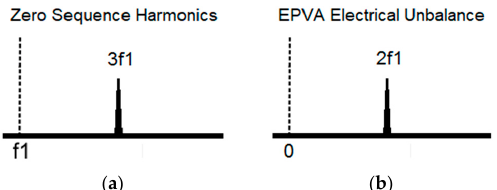
Figure 2. Fault patterns: ( a ) zero sequence harmonics; ( b ) EPVA electrical unbalance (patterns for stator electrical unbalance—electrical fault).